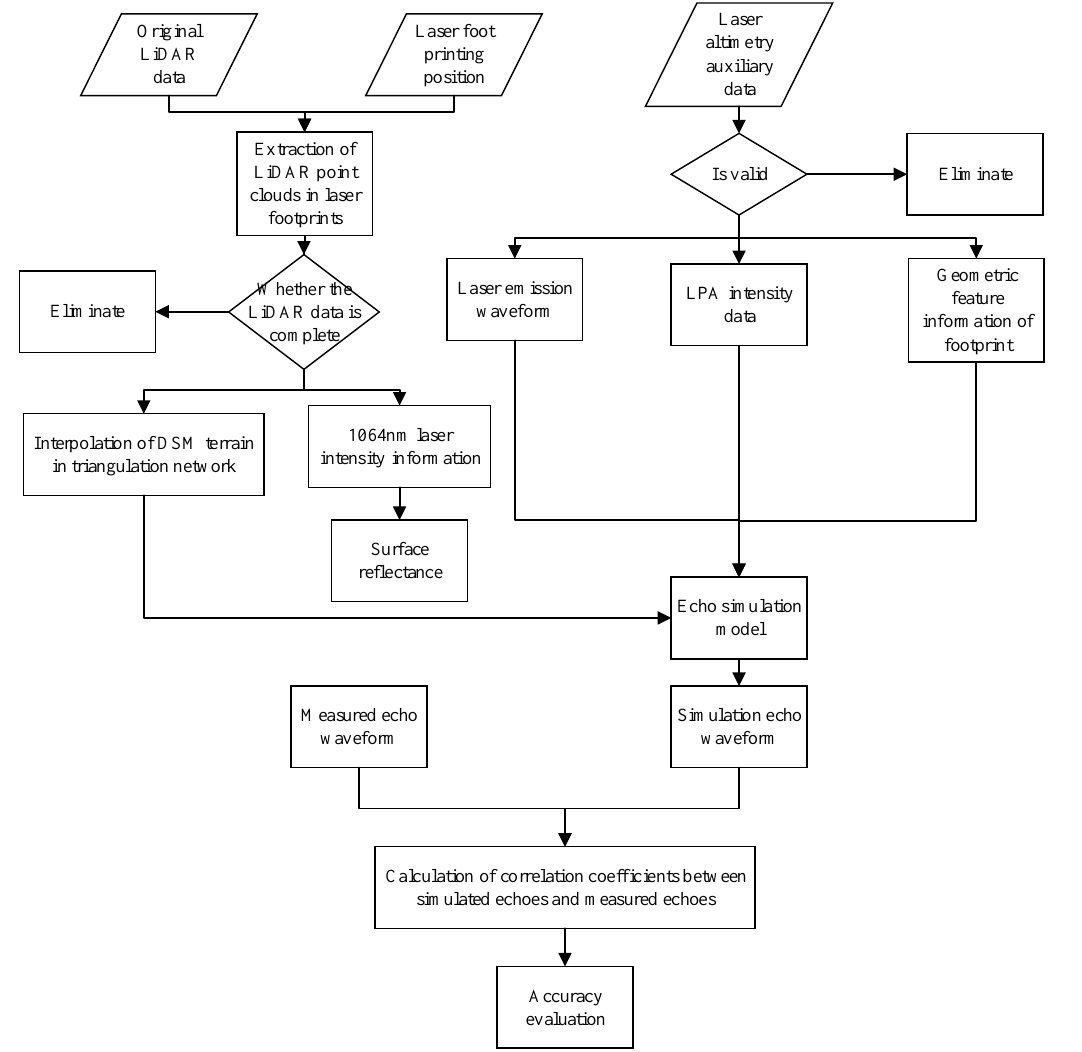
Figure 3. Flow chart of satellite echo simulation of satellite borne laser altimeter